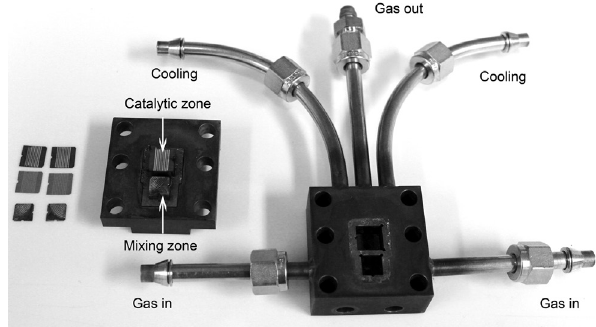
Figure 1 Gas-phase microreactor (GPMR)-mix from the Institut für Mikrotechnik Mainz